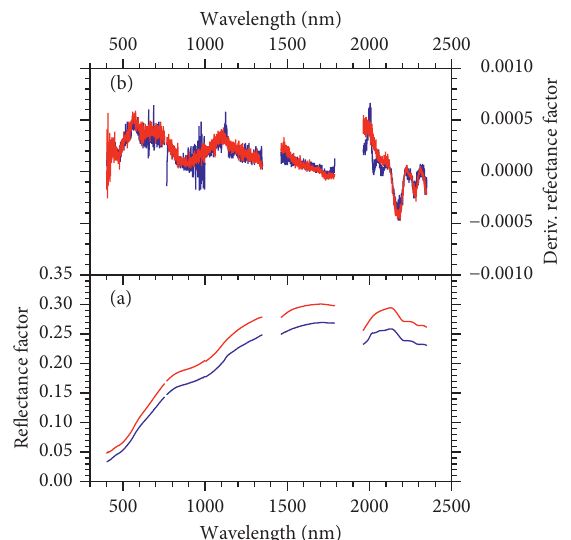
Figure 3: Spectral data with removed noisy regions (300–399, 1350–1640, 1790–1960, and 2350–2500nm): (a) untransformed and (b) first derivative transformation. Blue lines denote field spectral data and red lines denote laboratory spectral